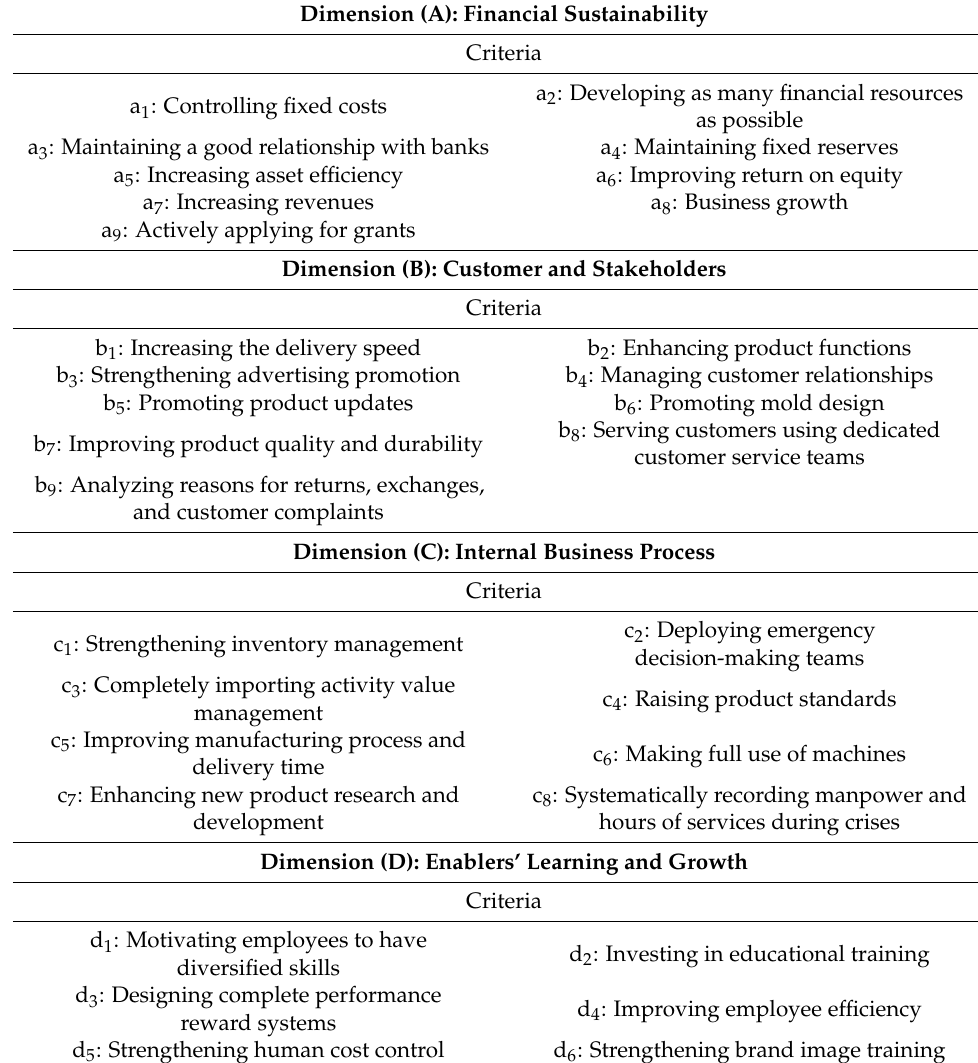
Table 1. Dimension and criteria of COVID-19 crisis management for the pre-test